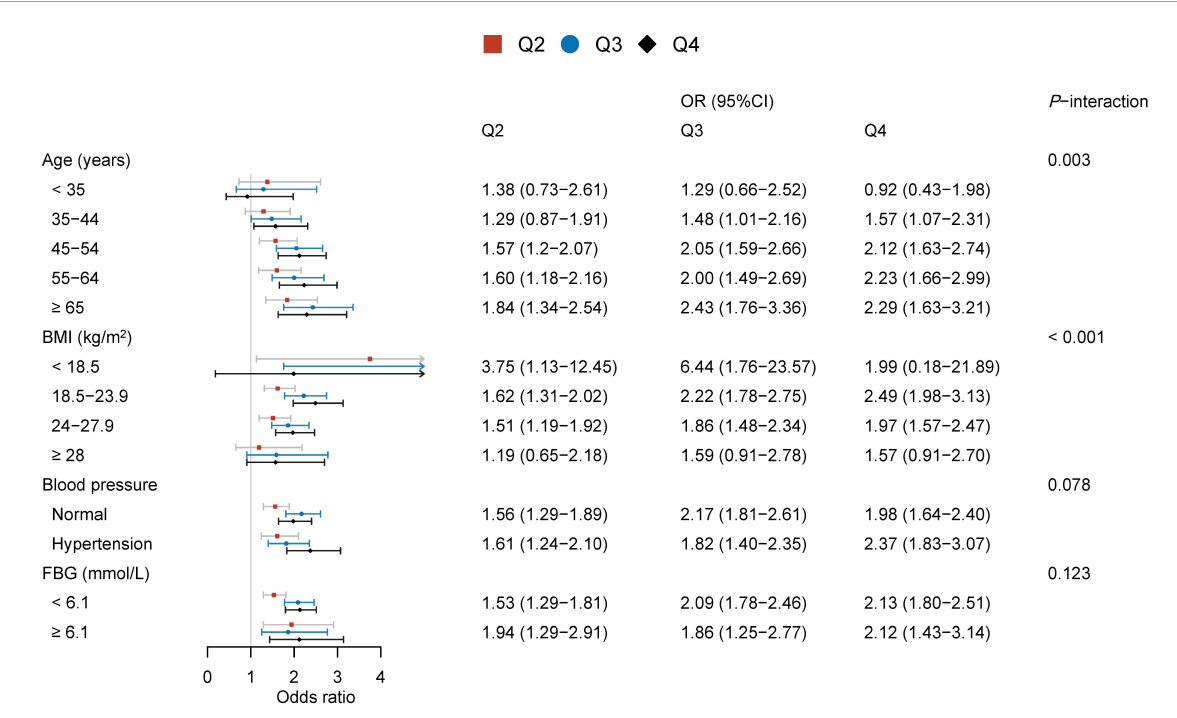
FIGURE2 Associations between TG/HDL-C and BPH in subjects with normal TG and HDL-C